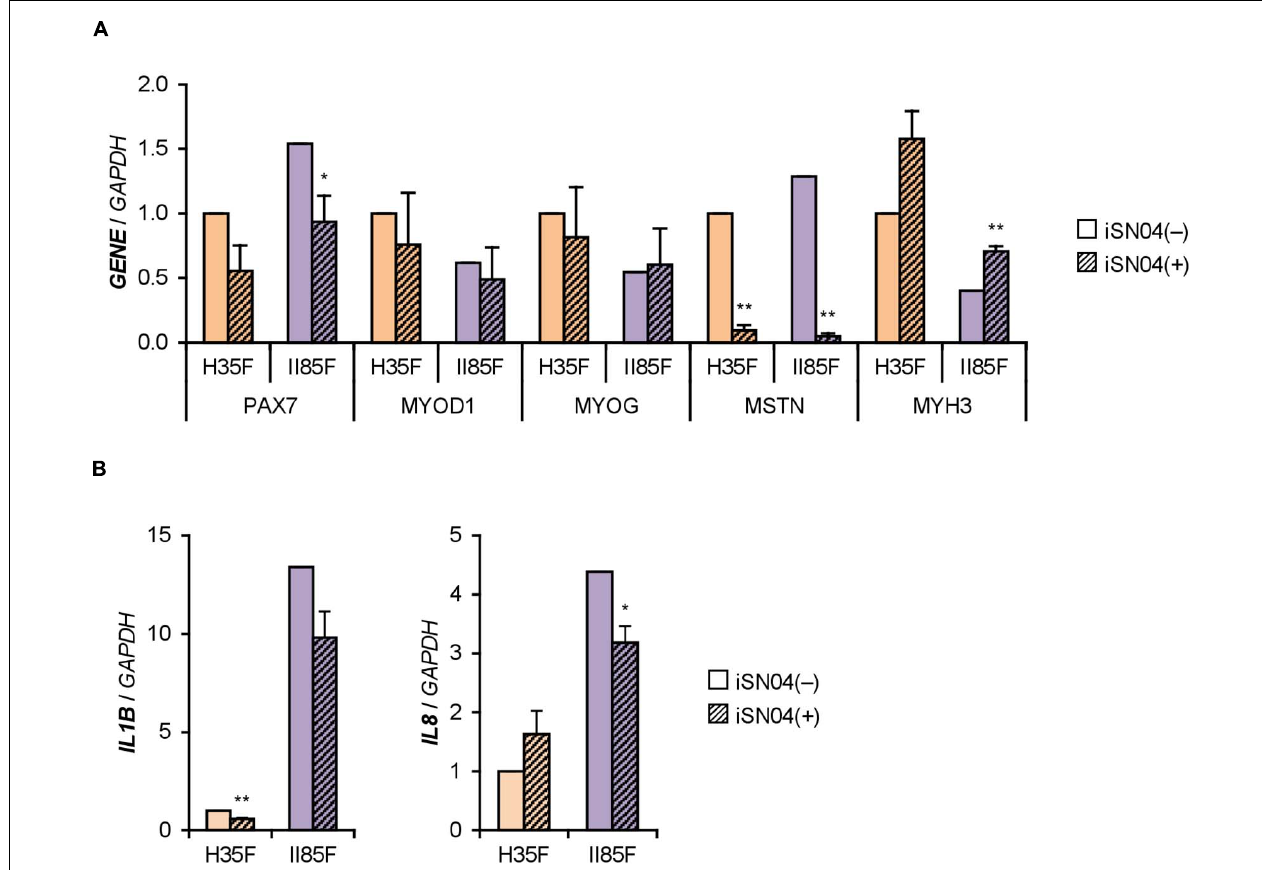
FIGURE 4 | iSN04 suppresses myostatin expression. (A,B) qPCR results of gene expression in the H35F and II85F myoblasts differentiated in DIM-NG with iSN04 for 2 days. Mean value of H35F-iSN04(–) group was set to 1.0 for each gene. * p < 0.05, ** p < 0.01 vs. iSN04(–) in each myoblast (Student’s t -test); n =